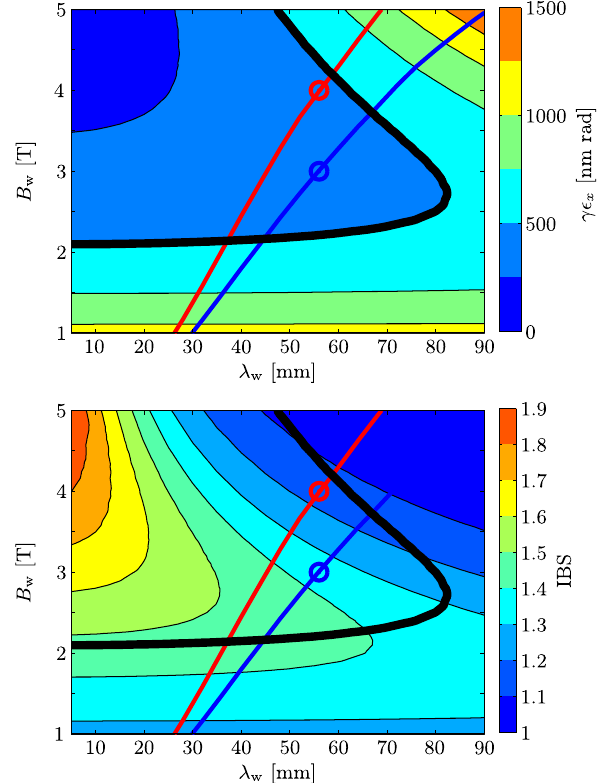
FIG. 6. Equilibrium normalized horizontal emittance (cid:3)(cid:4) and the effect of IBS ( (cid:3)(cid:4) show the maximum achievable magnetic flux density for superconducting wiggler magnets with Nb technology,